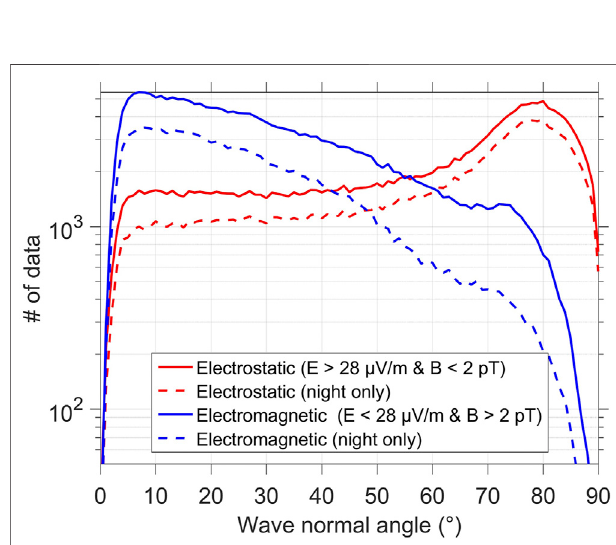
FIGURE 6 | Distribution (log10) of wave normal angle values for (red) electrostaticand(blue)electromagneticwaves.Electrostatic(electromagnetic) waves are more oblique ( fi eld-aligned). Dashed line is the distribution for nighttime